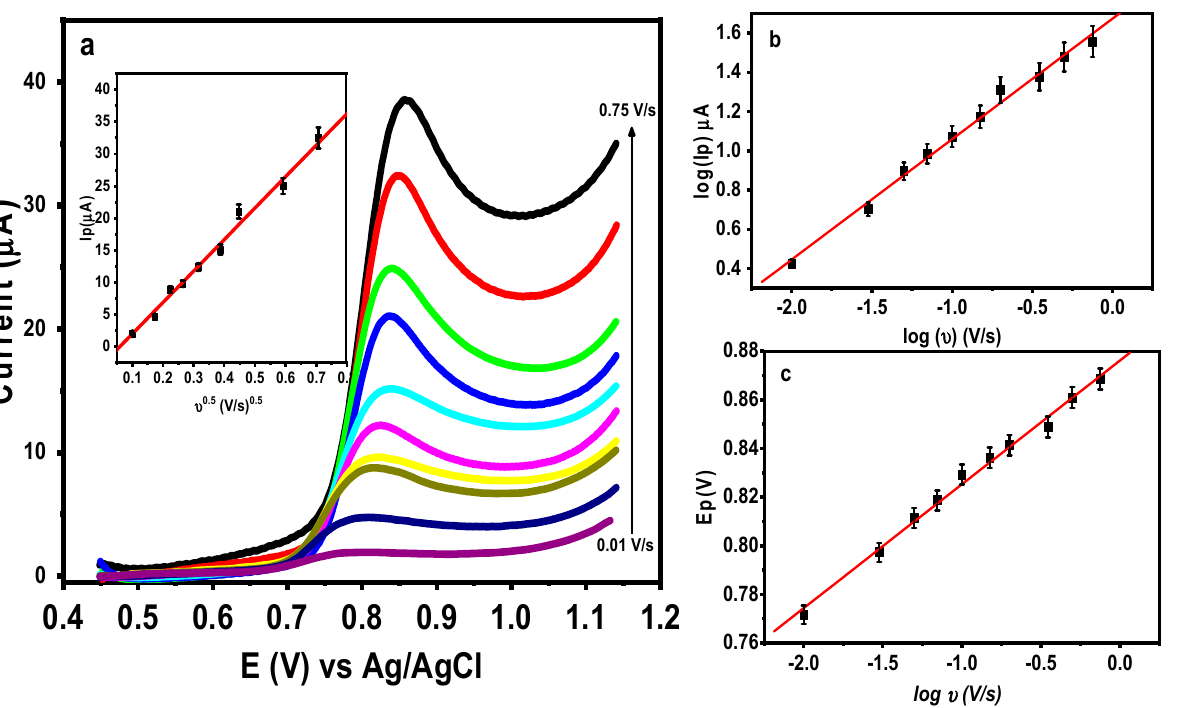
Figure 6. ( A ) CVs of 0.5 µM of DIC in 0.1 M of BR buffer (pH 3.0) at a scan rate 50 mV/s (a) unmod- ified CPE, (b) Chs NPs/CPE, and (c) M-Chs NC/CPE. ( B ) Two continuous cyclic voltametric scans of 0.5 µM of DIC solution in 0.1 BR buffer (pH 3.0) at scan rate 50 mV/s at M-Chs NC/CPE.